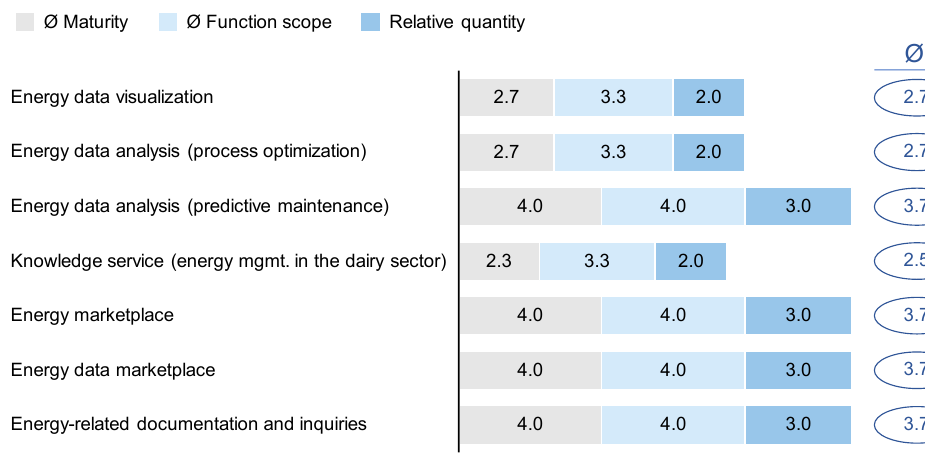
Figure 5. Maturity, function scope and relative quantity of DEMS in the as-is market offering tailored to German dairy farms.